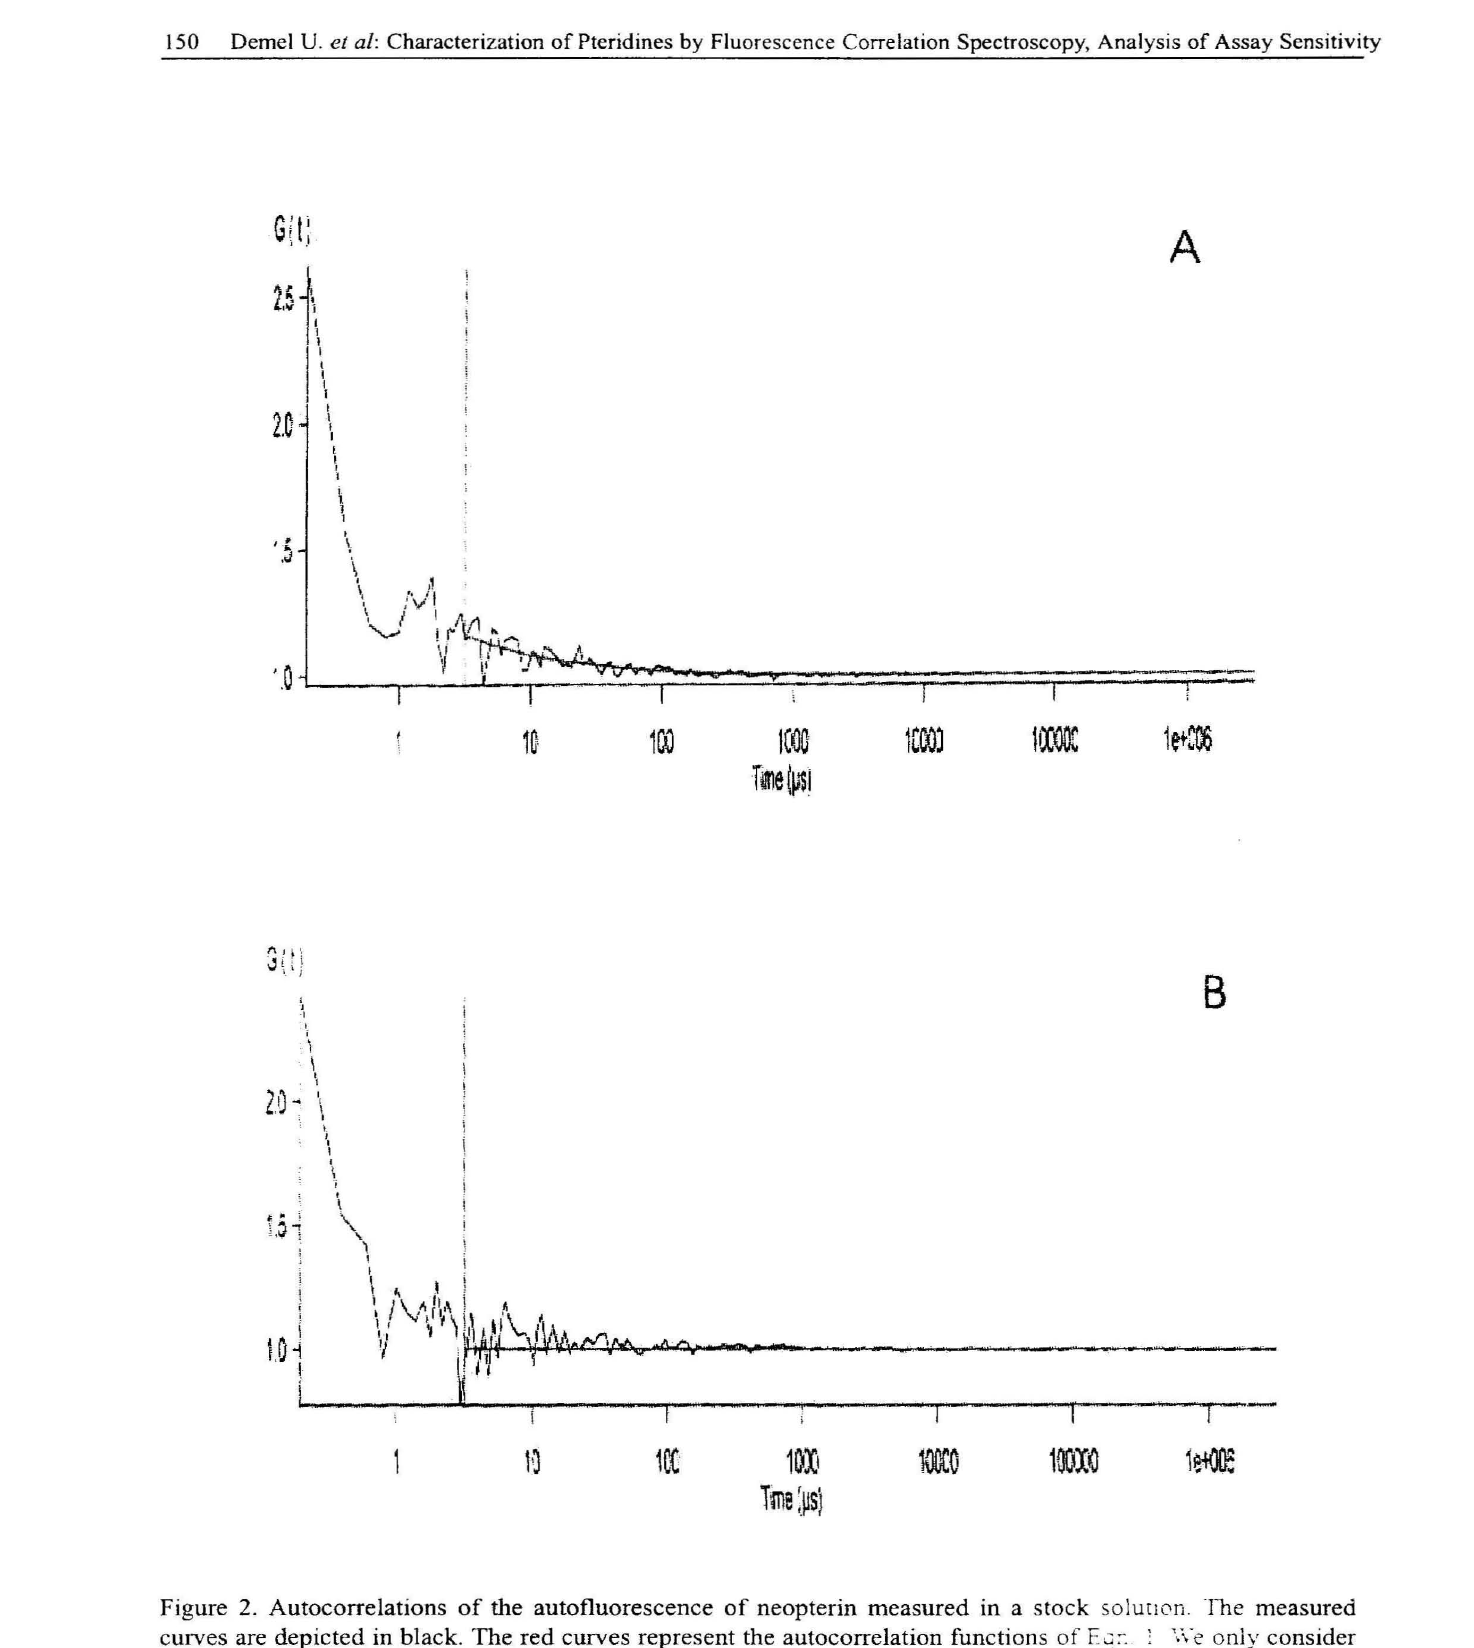
Figure 2. Autocorrelations of the autofluorescence of neopterin measured in a stock solutIon. The measured curves are depicted in black. The red curves represent the autocorrelation functions of Ew:, .. : \\-e only consider the physical process of three-dimensional diffusion of neopterin through the volume C'~:::-:::::'.: c',- detection. A: Stock solution ofneopterin. B: Solvent (aqua bidestillata) alone